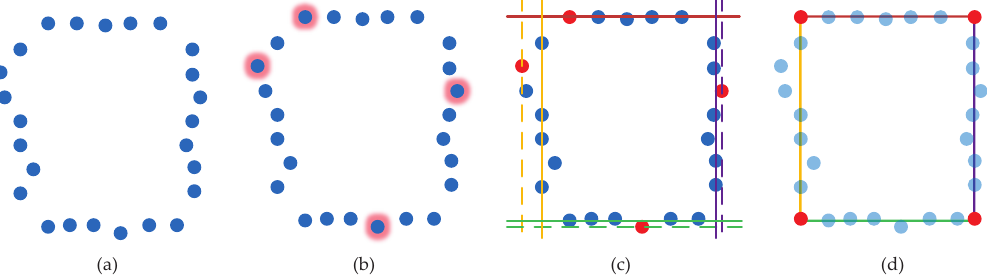
Figure 2. The pipeline for initial opening reconstruction. ( a ) Detected boundary points of an opening; ( b ) Extreme points of the opening borders; ( c ) Optimization of the boundary; ( d ) Reconstructed opening as